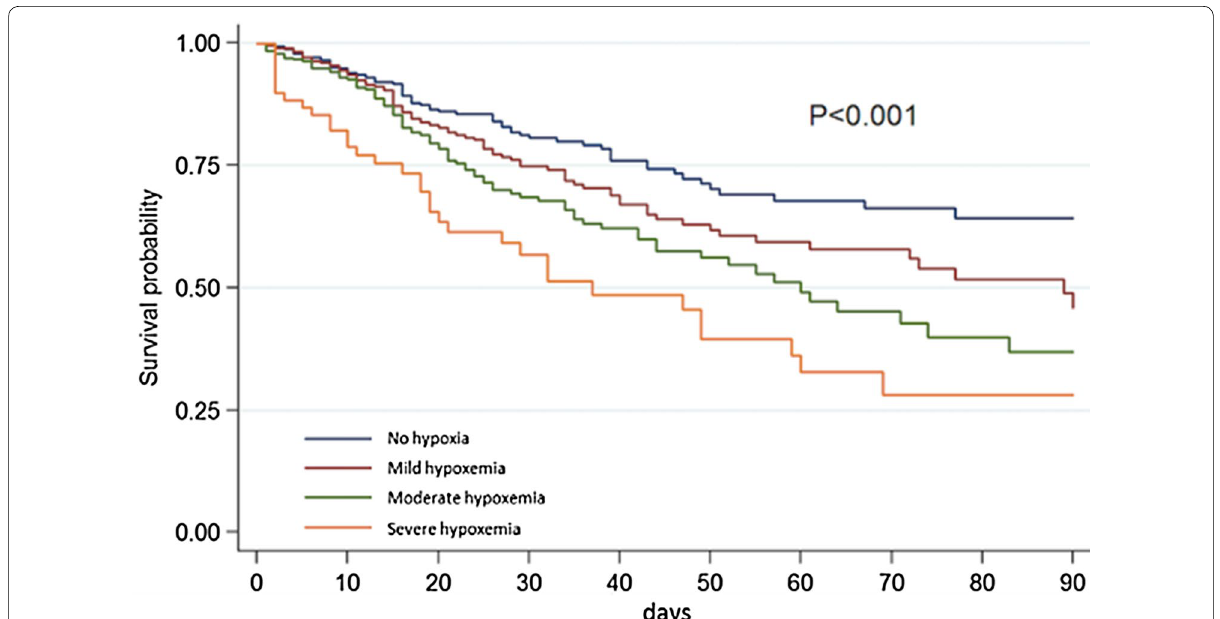
Fig. 2 Survival curve according to hypoxemia severity. Survival curves were drawn according to the severity of hypoxemia using the Kaplan–Meier method and were compared using the log-rank test. Follow-up ended at the ICU leaving or was censored at day 90